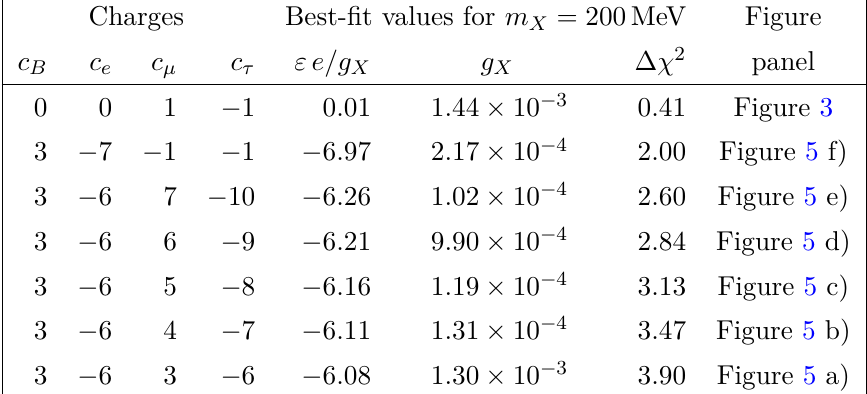
Table 1 . The U(1) X charges parametrized by c B,e,µ,τ in (4.3) (first four columns), and the best-fit values of the mixing parameter (fifth column) and gauge coupling (sixth column), as well as the χ 2 value at the minimum taking m = 200 MeV, for vector-like U(1) models that can explain the X X measurement of ( g − 2) within 2 σ and pass the bounds from NSI osc., COHERENT, Borexino, µ NA64, and BaBar.